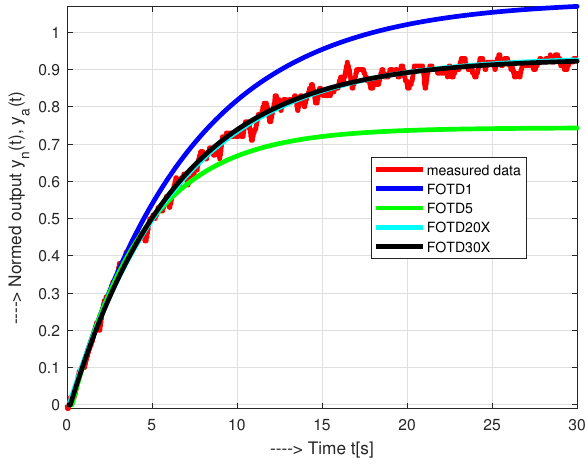
Figure 11. FOTD approximations of a normed step response y n ( t ) calculated for t a ≤ 1, t a ≤ 5, t a = 20 and t a = 30.